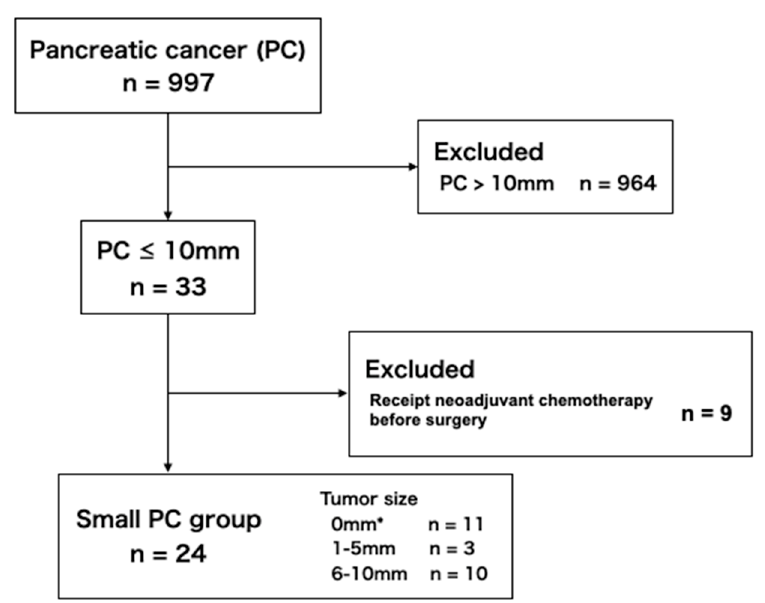
Figure 3. Flow-chart of the inclusion of patients in the small pancreatic cancer group. * Carcinoma in situ.